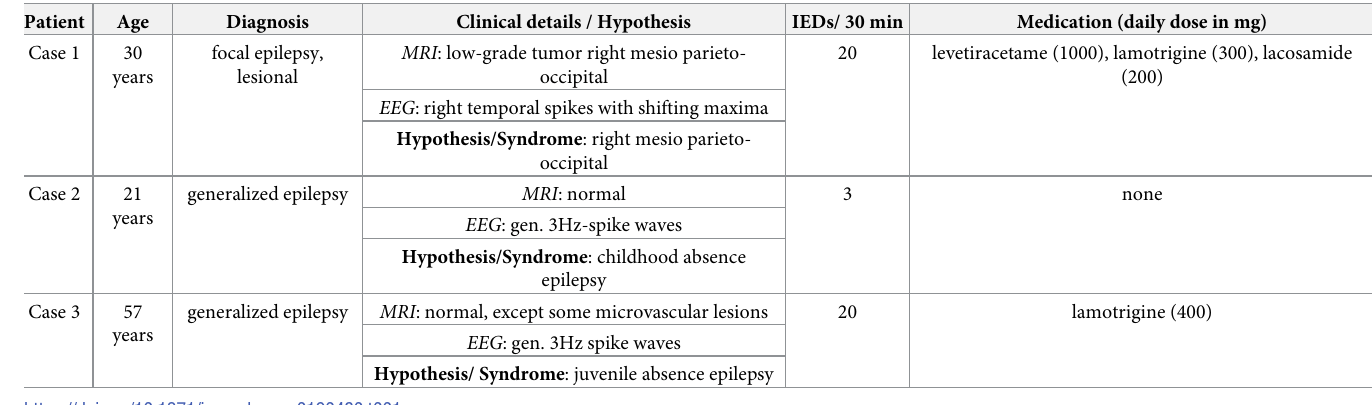
Table 1. Clinical data of epilepsy